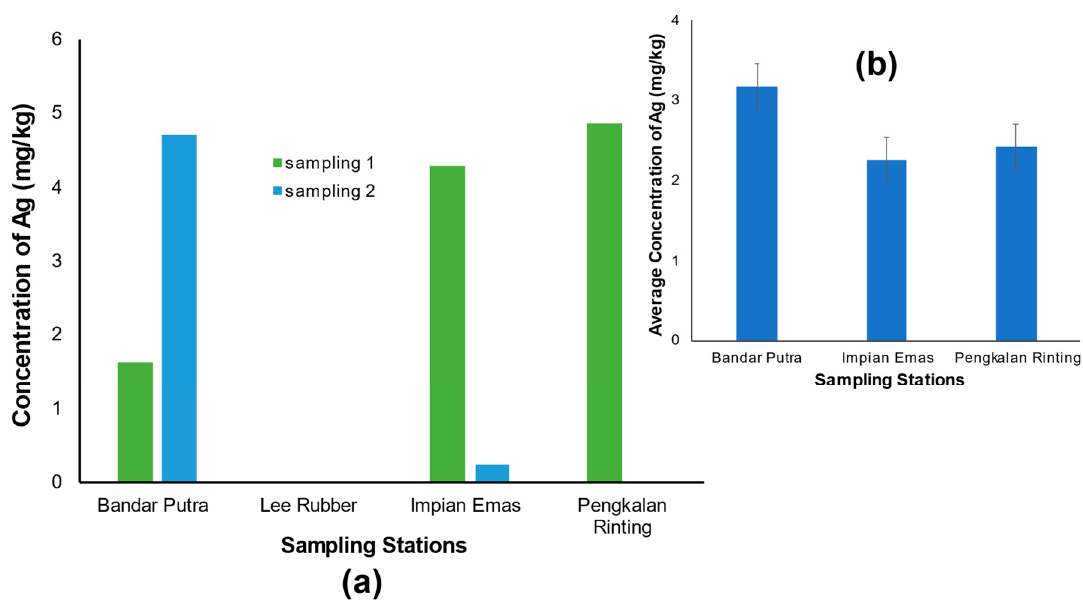
Figure 6. ( a ) Ag concentrations in plant samples over sampling period and ( b ) average Ag concen- trations by sampling station.